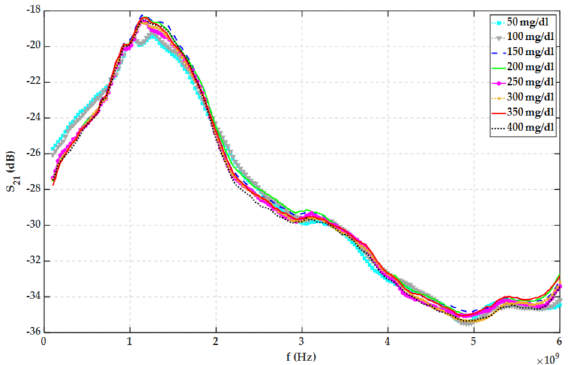
Figure 8. Measured scattering parameters regarding water with the different glucose content.